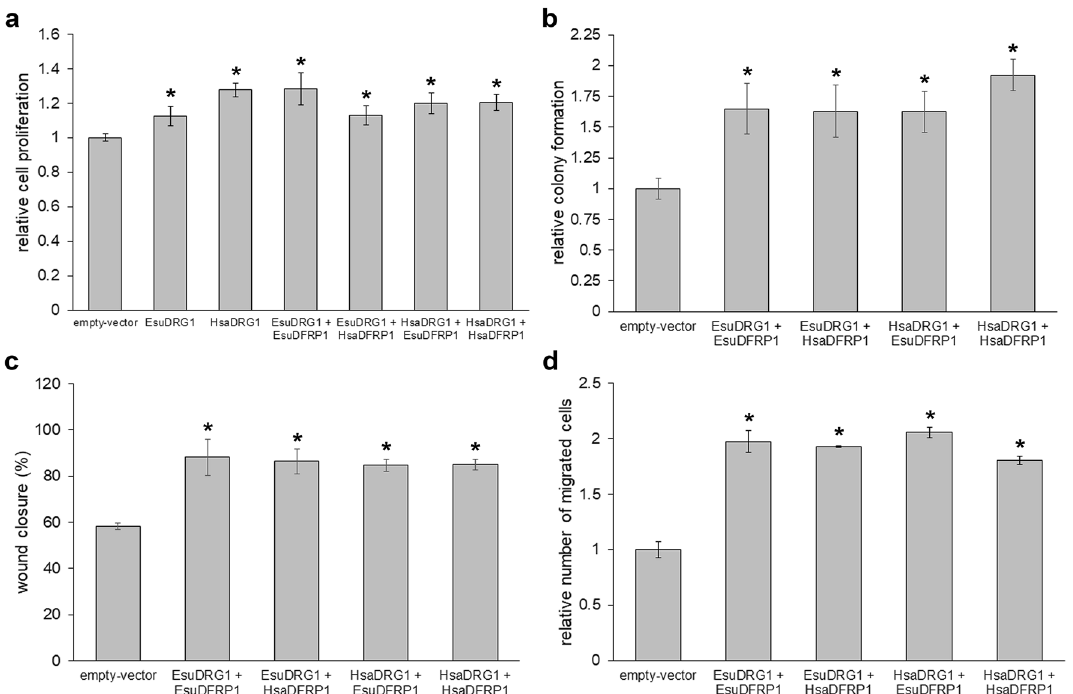
Figure 11. Both sponge and human DRG1 increase cell proliferation, colonization and migration of MDA-MB-231 cells. The function of sponge DRG1 is regulated by sponge or human DFRP1 in ( a ) cell proliferation, ( b ) colony formation, ( c ) wound healing and ( d ) cell migration in co-transfected MDA-MB-231 cells and compared to human DRG1. Quantification was done using the ImageJ software (National